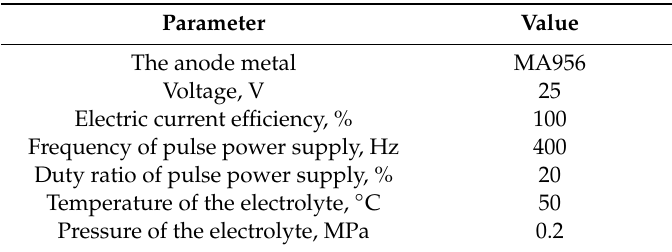
Table 3. Optimized ECM treatment parameters.